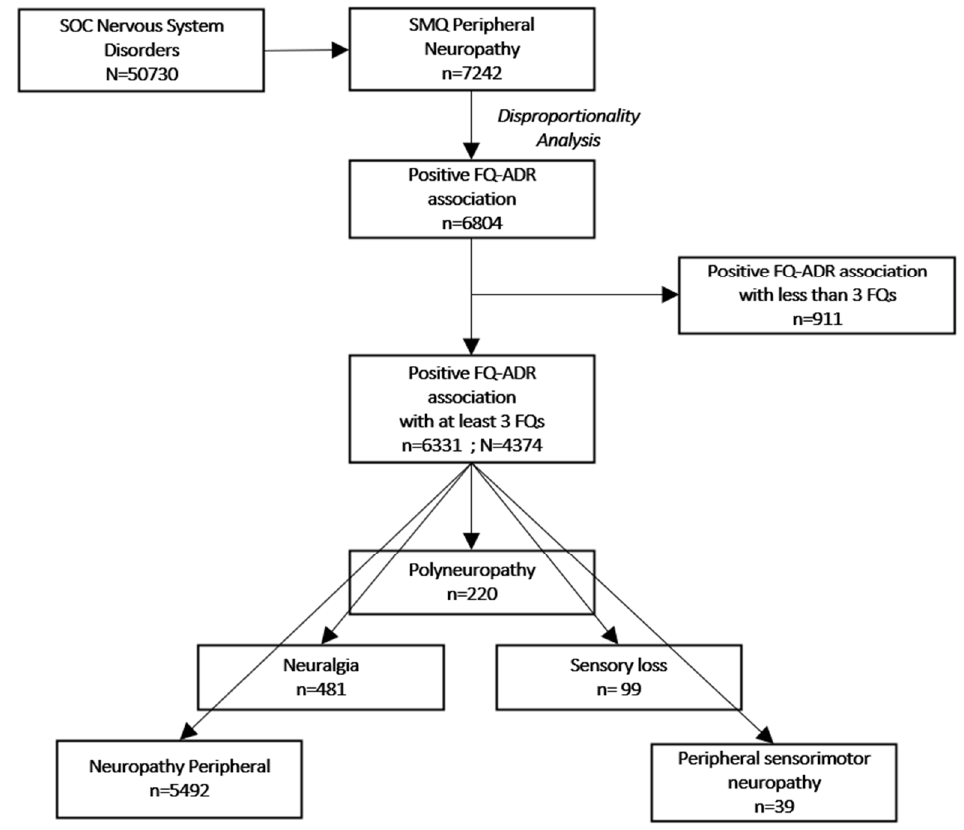
Figure 1. Flowchart of selection criteria. ADR: adverse drug reaction; FQ: fluoroquinolone; SOC: system organ class (MedDRA); SMQ: standardized MedDRA queries; N: number of reports; n: number of adverse drug